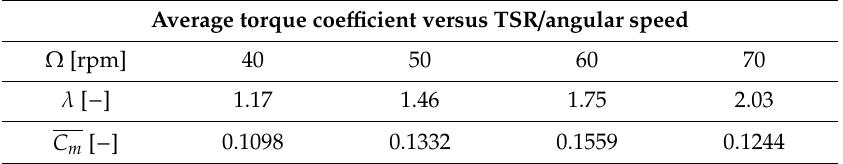
Table 1. Computed averaged turbine torque coe ffi cient depending on rotational velocity and λ